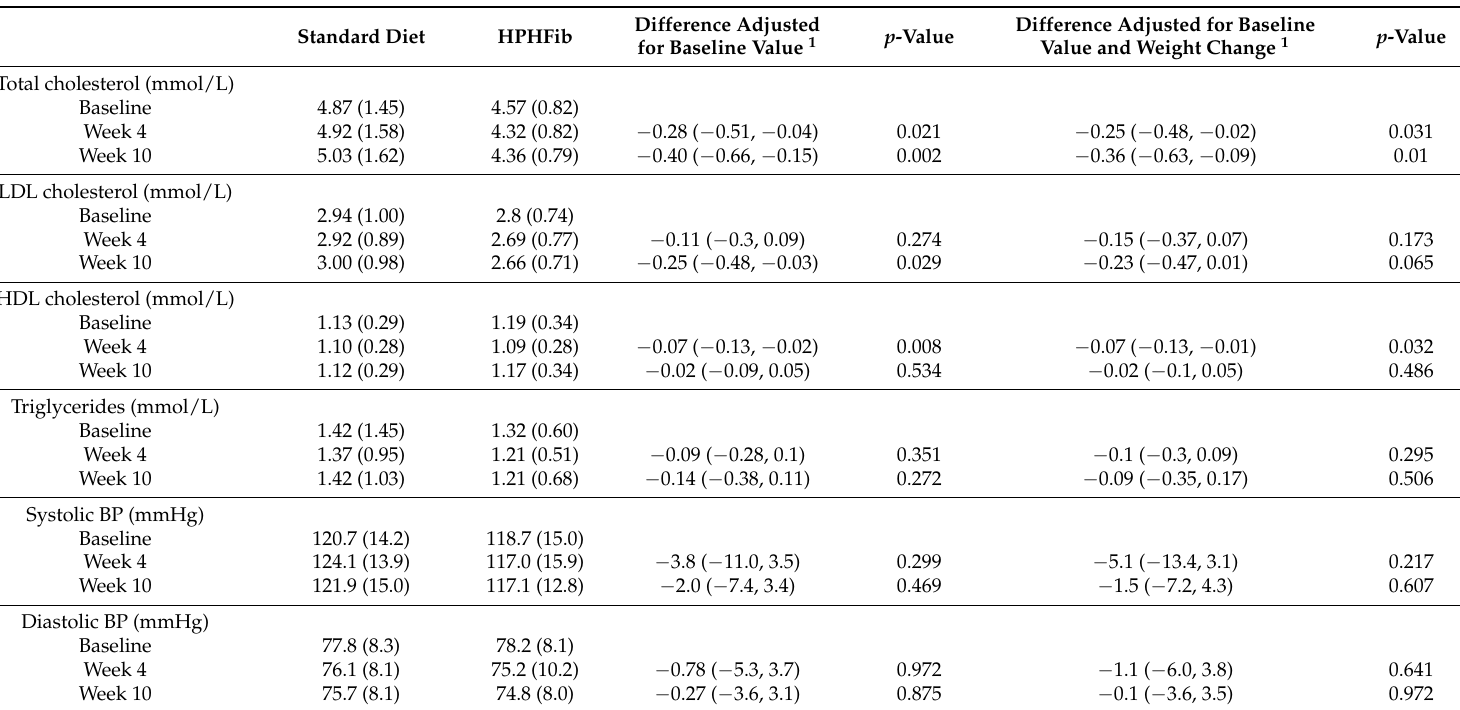
Table 6. Mean (SD) measures for other metabolic variables based on fasting blood samples and clinical measures at baseline, week 4 and week 10 and percentage differences between dietary groups, adjusted for baseline values and weight